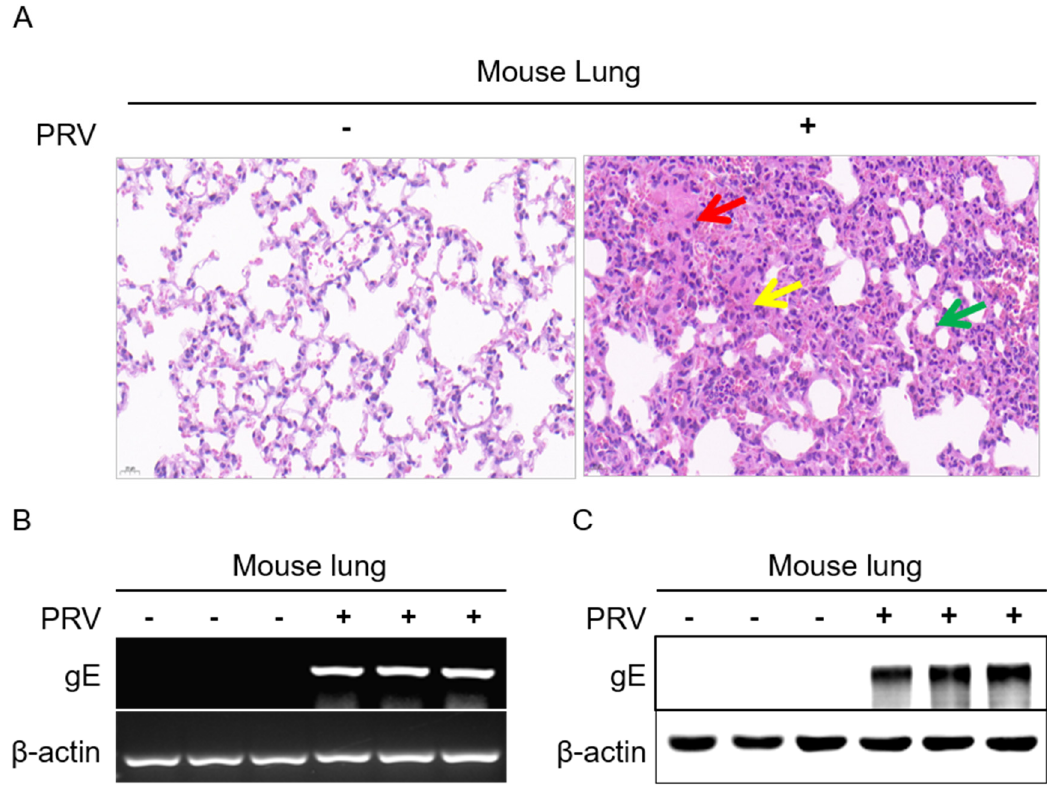
Figure 1 . The identification of PRV − infected mice. ( A ) The histopathology of mice lungs was observed by HE staining (40×) results, consolidation of tissue (red arrow), internal hemorrhage of tissue (yellow arrow), markedly enlarged alveolar septa (green arrow); ( B ) The expression of PRV gE gene in mouse lung tissues were analyzed by PCR; ( C ) The expression of PRV gE protein in mouse lung tissues were investigated by Western blotting. β‐ actin was used as reference housekeeping genes for internal standardization.